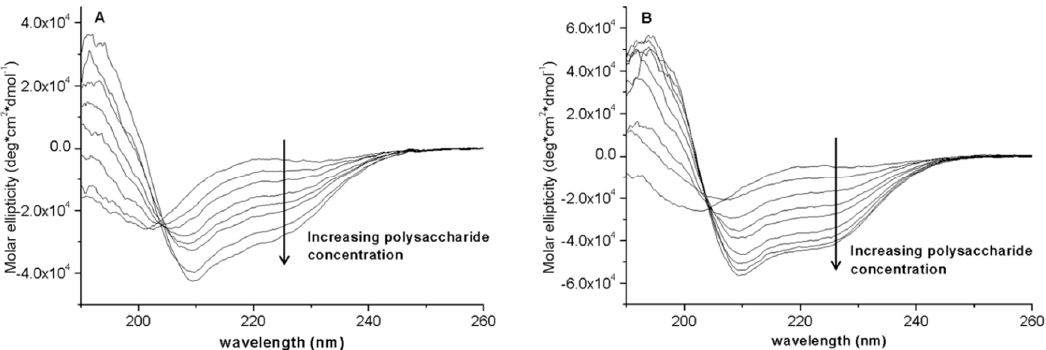
Figure 6. Concentration-dependent circular dichroism spectra of BMAP-27 as a function of increasing amount of ( A ) EPOL Kp113; and ( B ) EPOL Kp101. [BMAP-27] = 20 µM. Polysaccharide amount of ( A ) EPOL Kp113; and ( B ) EPOL Kp101. [BMAP-27] = 20 µ M. Polysaccharide concentrations: concentrations: EPOL Kp113 from 0 to 400 µM, moles of pentasaccharide; EPOL Kp101 from 0 to 380 EPOL Kp113 from 0 to 400 µ M, moles of pentasaccharide; EPOL Kp101 from 0 to 380 µ M, moles µM, moles of pentasaccharide. Solvent: phosphate buffer 10 mM, pH 7.4.